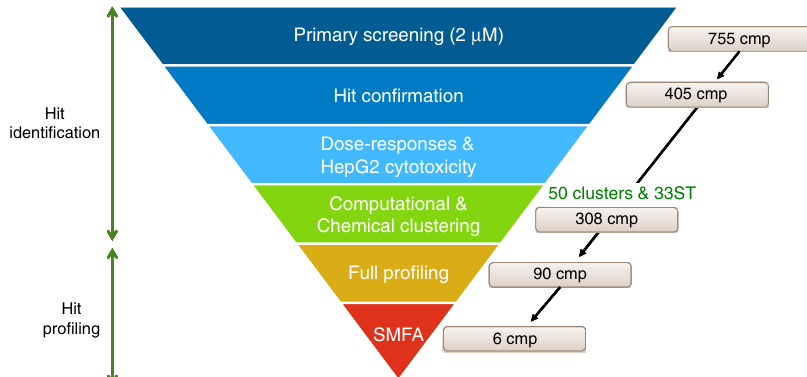
Figure 1 | Progression cascade of the TCAMS screen in the Pf FGAA. The different steps followed during the TCAMS screen as well as the number of compounds identified in the first phases and those selected for further profiling are shown. The first four steps can be defined as ‘hit identification’. After clustering, compounds are progressed to characterize their biological profiles and finally tested in the gold standard